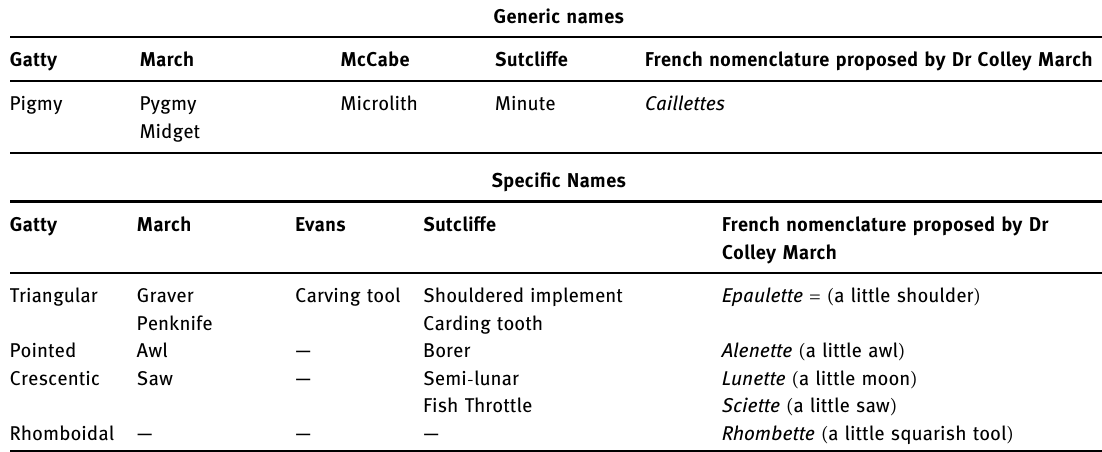
Table 1: Nomenclature of small fl int implements proposed at the Special Meeting and Exhibition of Pigmy Implements, Manchester Museum, 1 February 1912 ( after Sutcli ff e et al., 1913, p. 27